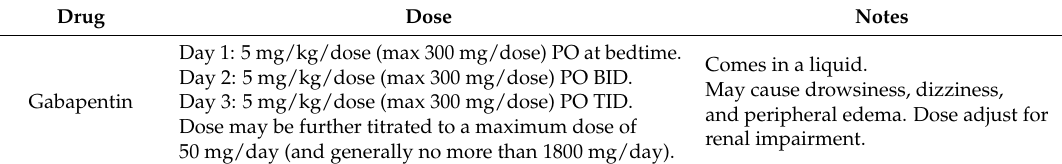
Table 6. Neuropathic